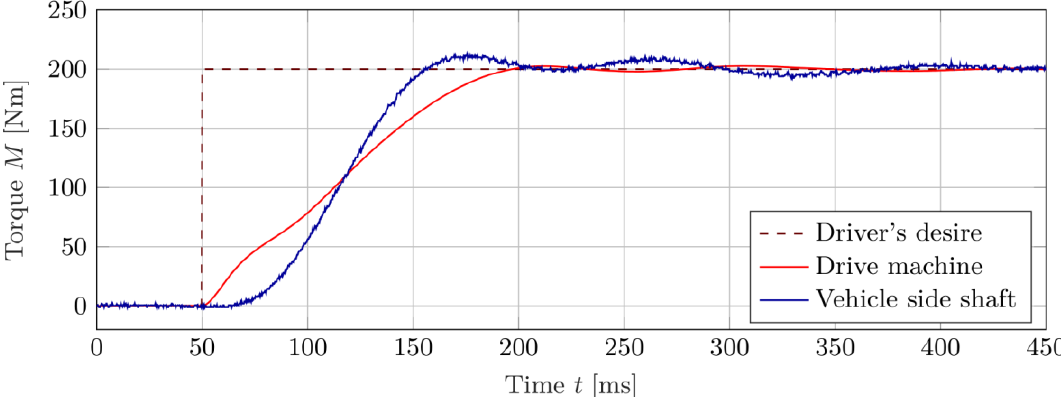
Figure 15. Torque curves as a result of the setpoint step in the driver′s desired torque with prefilter and active anti-jerk control while driving off. active anti-jerk control while driving o ff